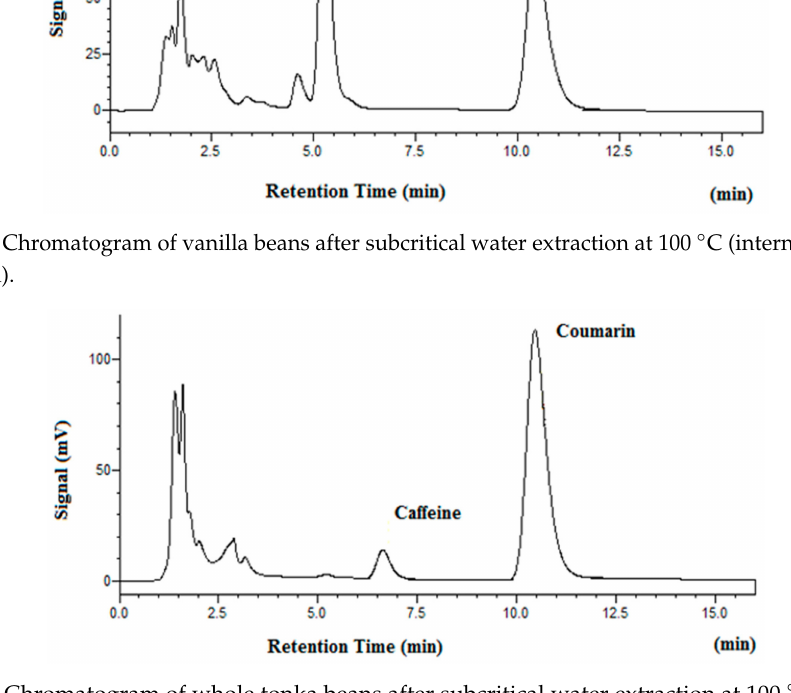
Figure 6. Chromatogram of whole tonka beans after subcritical water extraction at 100 ◦ C (internal standard: ca ff eine). Table 4. Comparison of analyte quantity from vanilla beans obtained by 30-min subcritical water extraction and sonication